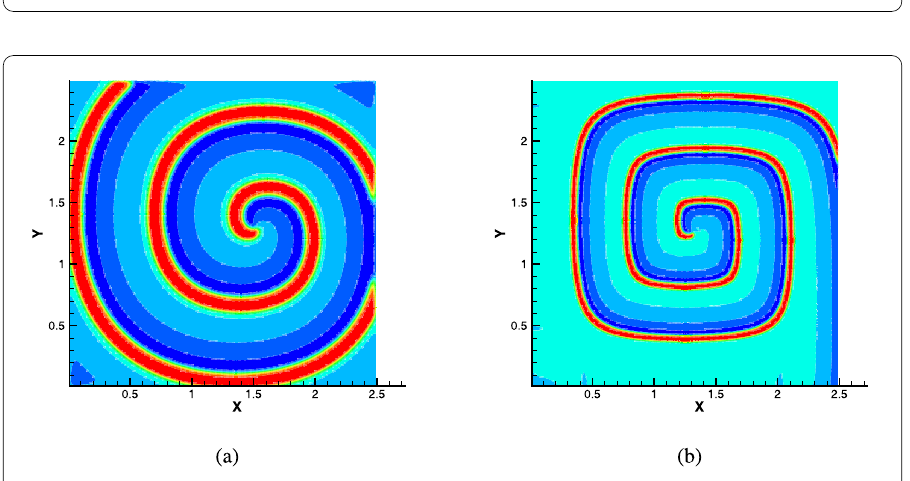
Figure 2 Solutions of Example 2 with K x = K y = 1 E – 4 for varying fractional power: ( a ) α x = α y = 1.8 and ( b ) α x = α y =